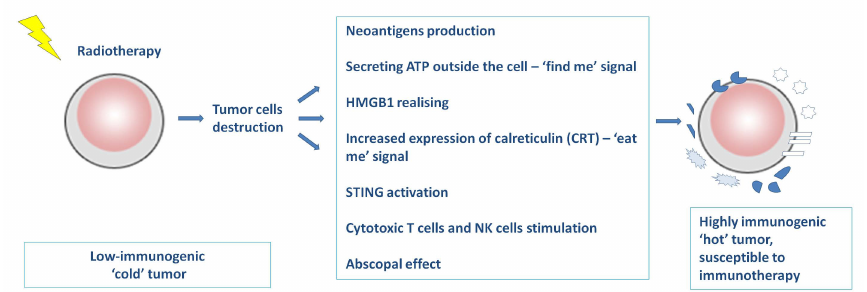
Figure 1. The mechanism of radiation therapy on cancer cells and its influence on the immune